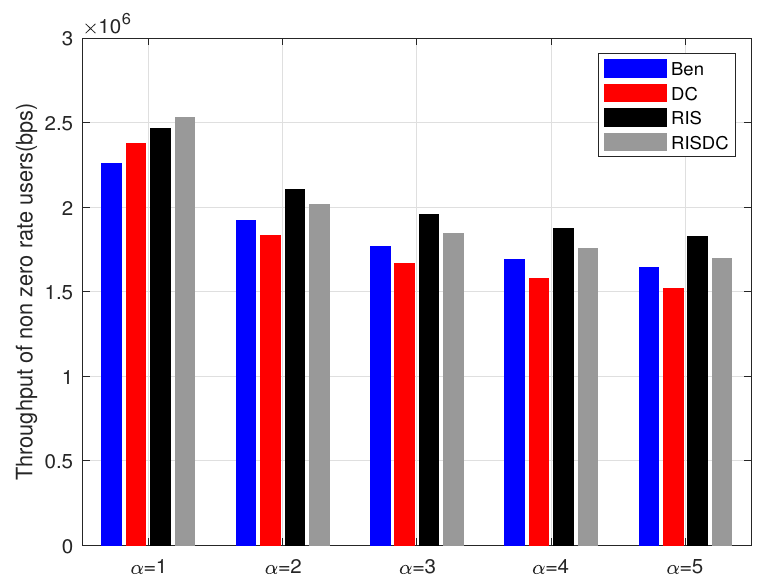
Figure 10. Variation of non zero rate users’ throughput for different α s when ρ bs = 2, ρ user = 60, ρ ris = 6, and µ b =